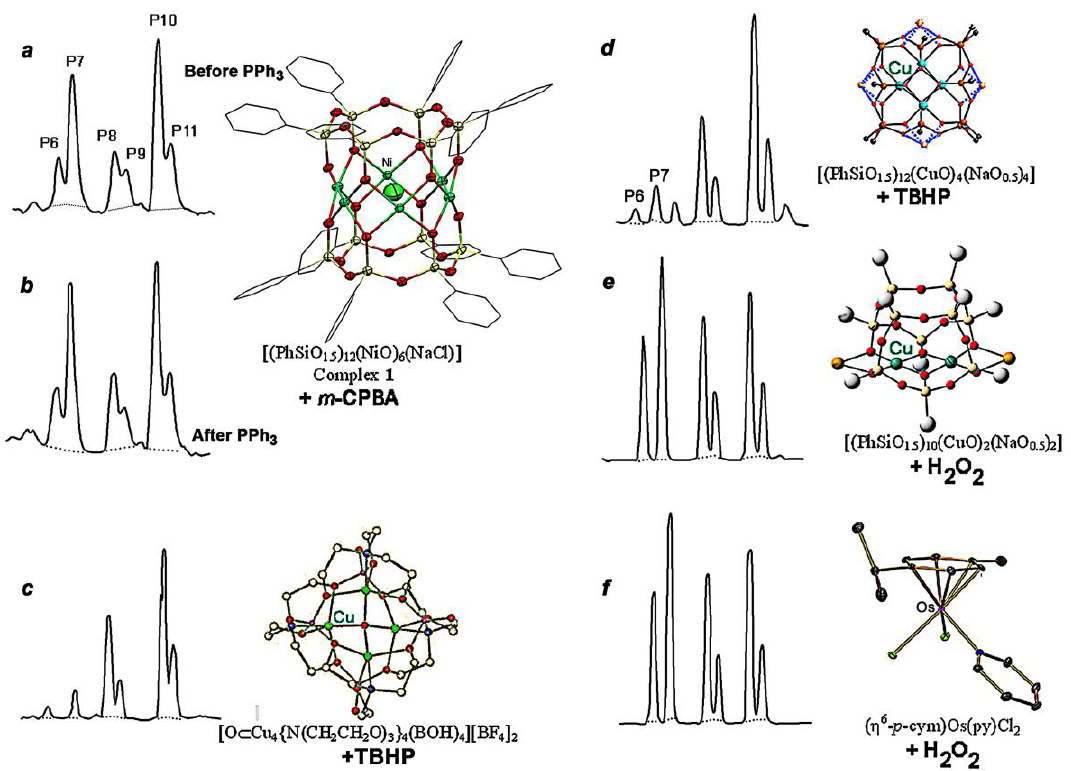
Figure 6 Figure 6. Chromatograms (fragments) of products formed in the methylcyclohexane oxidation by various systems: complex 1 / m -CPBA ( a , b , this work); [O Ă Cu 4 {N(CH 2 CH 2 O) 3 } 4 (BOH) 4 ][BF 4 ] 2 /TBHP ( c , [52]); [(PhSiO 1.5 ) 12 (CuO) 4 (NaO 0.5 ) 4 ]/TBHP ( d , [19]); [(PhSiO 1.5 ) 10 (CuO) 2 (NaO 0.5 ) 2 ]/H 2 O 2 ( e , [19]); ( η 6 - p -cym)Os(py)Cl 2 /py/H 2 O 2 ( f ,